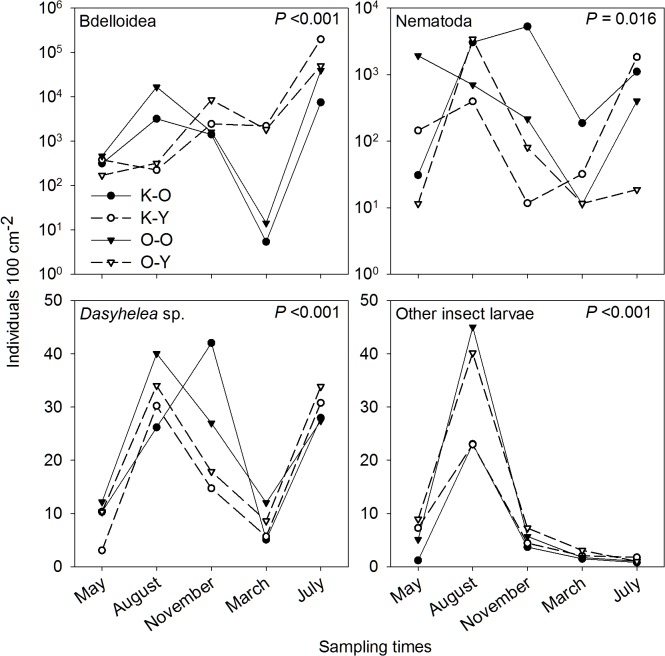
Mean abundances of Bdelloidea, Nematodes, and Dasyhelea sp. and other insect larvae per 100 cm2.The SD’s are listed in S1 Table. The data are given for the four sampling sites, K-O (Kühnauerheide, old forest), K-Y (Kühnauerheide, young forest), O-O (Oranienbaumer Heide, old forest), and O-Y (Oranienbaumer Heide, young forest), at the five sampling times. Note the differences in the y-axes. The p-values (Kruskal-Wallis test) indicate the overall impact of the sampling date on the taxon.